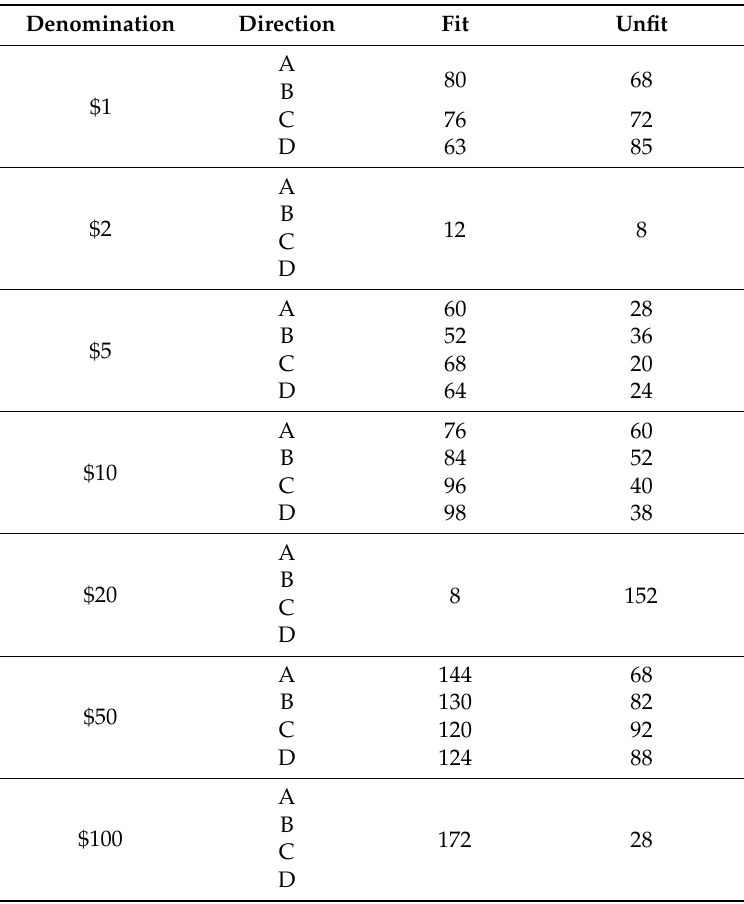
Table 4. Number of fit and unfit images of US dollar